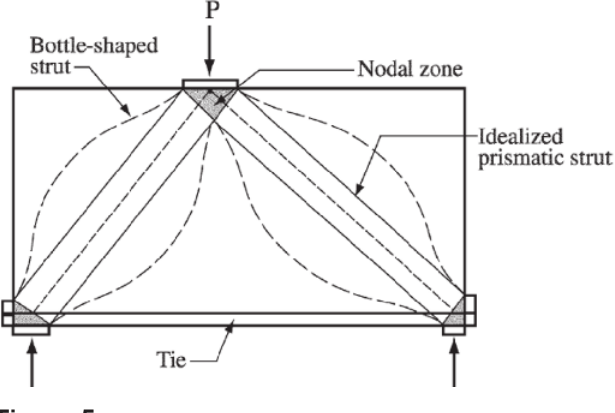
Strut-and-tie Model of a simply supported beam ([5] and